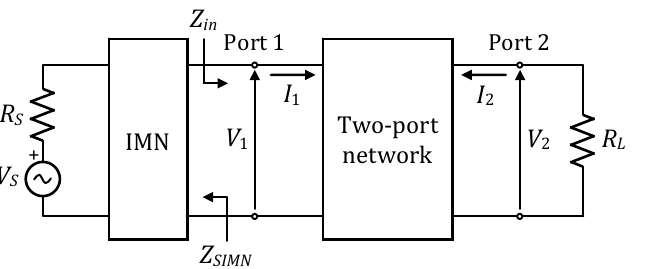
Figure 4. The magnetically coupled resonant wireless power transmission system with the impedance matching network (IMN), represented as a two-port passive linear network model with the generalised S-parameters.